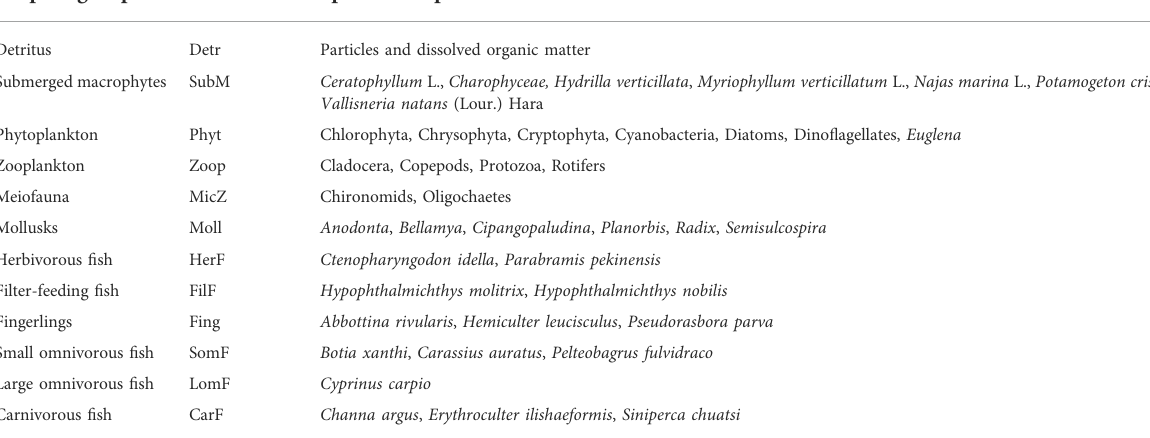
TABLE 1 Trophic groups used to construct the food web models of Lake Baiyangdian. Trophic